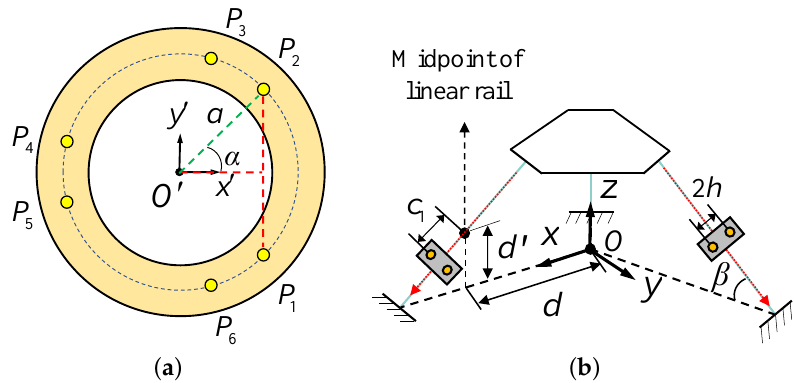
Figure 2. ( a ) Diagram of moving platform. ( b ) Diagram of